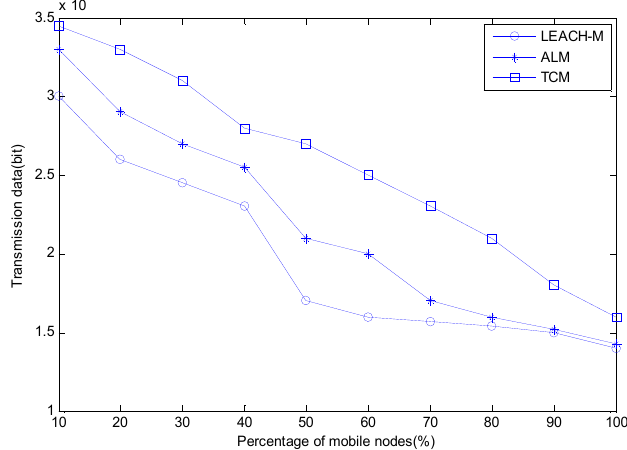
Figure 8. The relationship of transmission data and the percentage of mobile nodes.